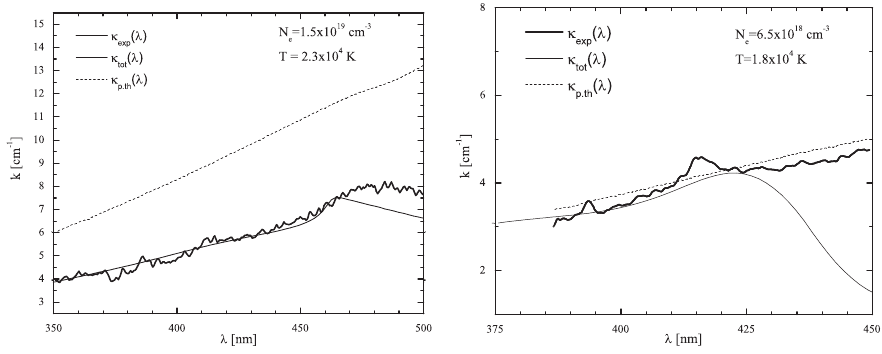
Fig. 3. The absorbtion coefficient (cid:20) tot ( (cid:21) ) calculated in the case of the short pulse with ∆ n = 0 : 455 eV and (cid:14) n = 0 : 625 eV. Dashed line is the theoretical curve from Vitel et al. (2004).